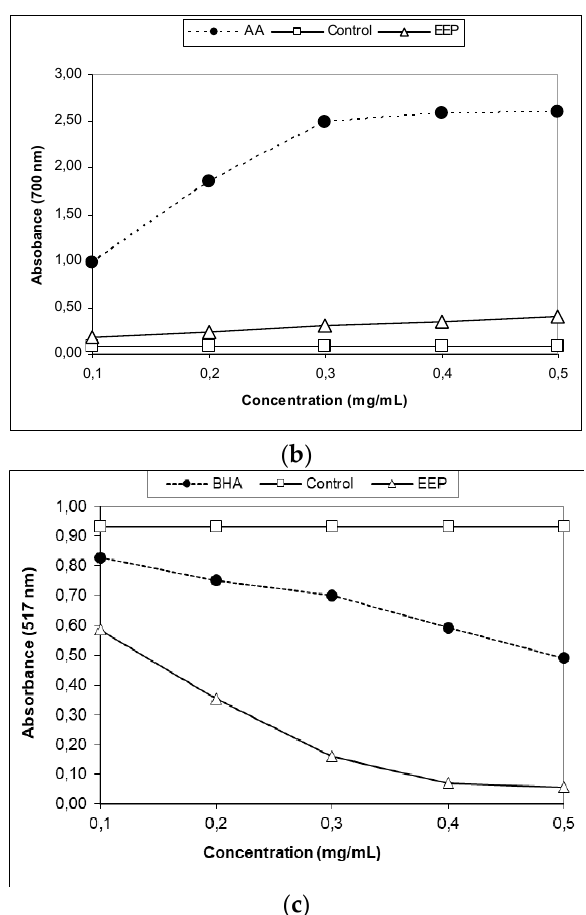
Figure 3. Antioxidative capacity of ethanol extract of propolis analyzed by three different methods: ( a ) β -carotene bleaching (BCB) assay, ( b ) the reducing power of the extracts, ( c ) 2,2-diphenyl-1-picrylhydrazyl radical-scavenging (DPPH) radical-scavenging activity. BHA: butylated hydroxy-anisole; AA: ascorbic acid; EEP: ethanol extract of propolis.